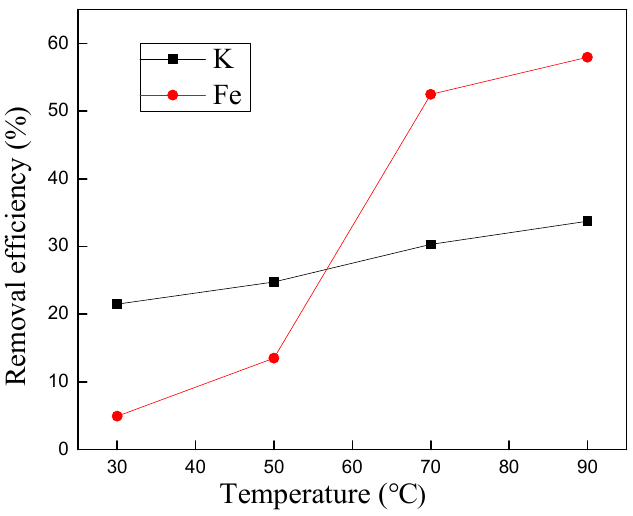
Figure 8. Effect of temperature on the removal efficiency.